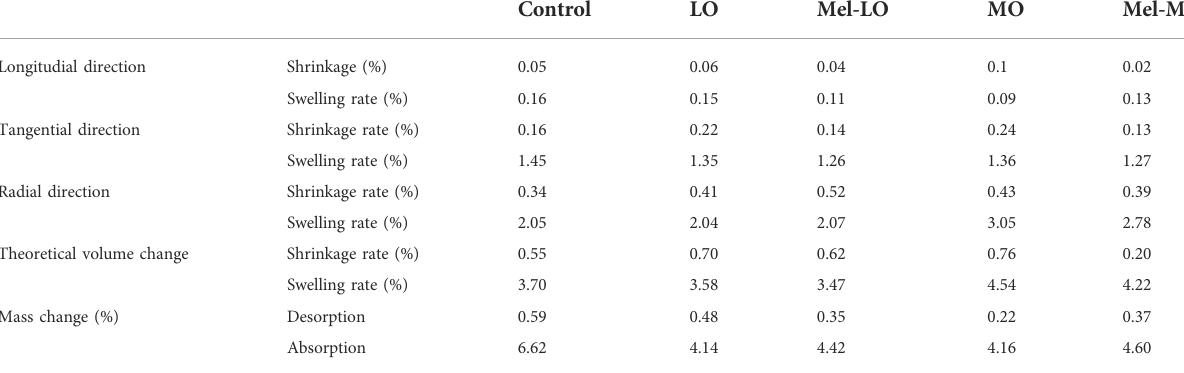
TABLE 3 Shrinkage and swelling rate of walnut wood after different treatments with plant oils and melanin. Control LO Mel-LO MO Mel-MO Longitudial